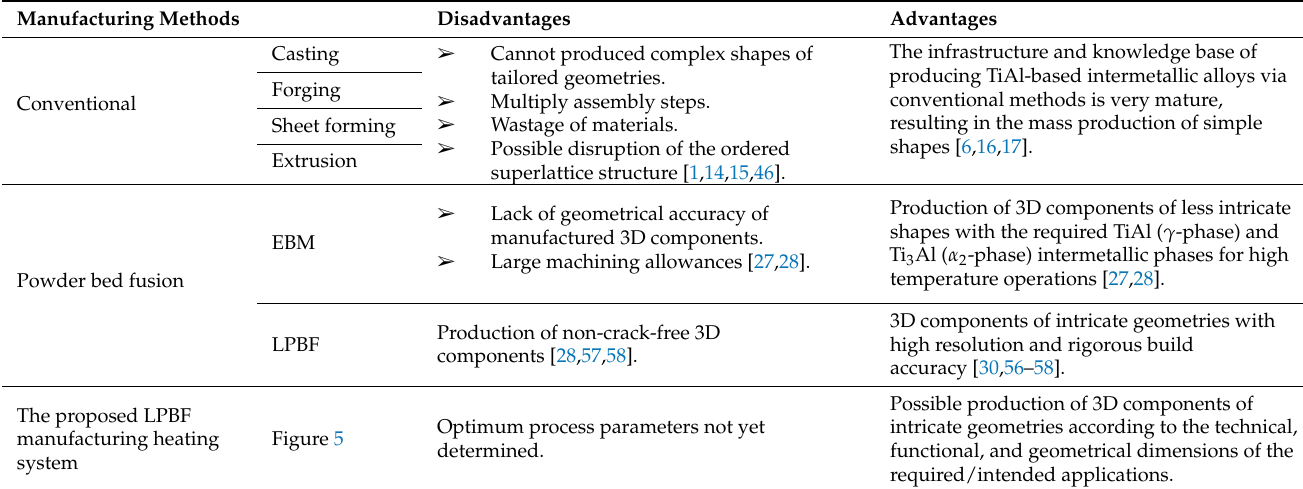
Optimum process parameters not yet